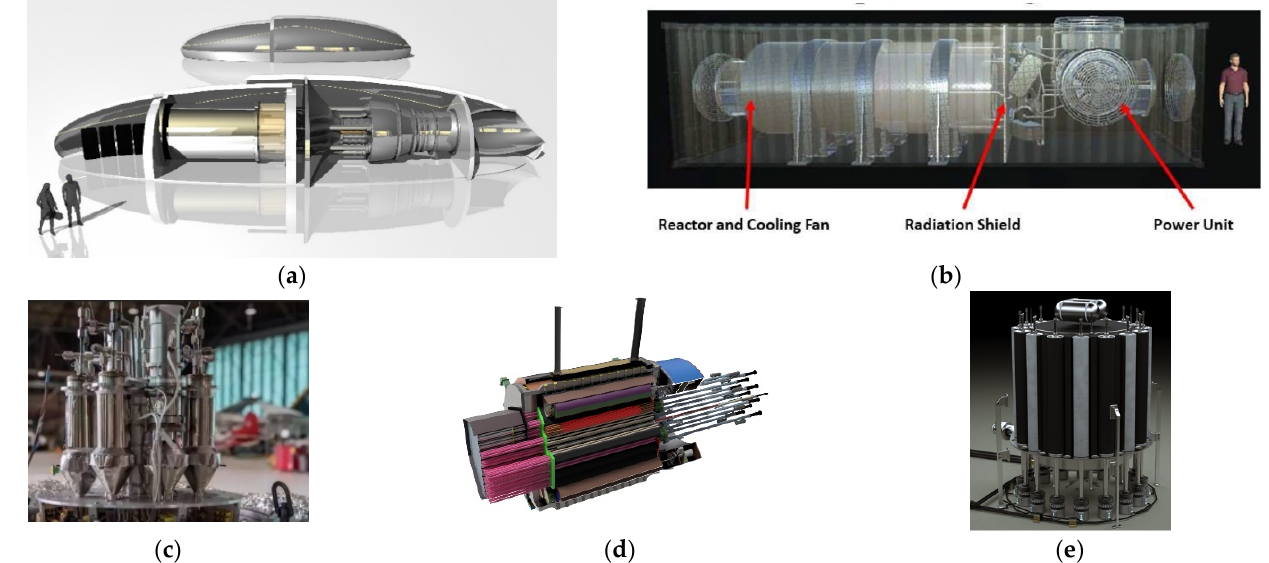
Figure 1. ( a ) MIT’s conceptualization of a nuclear battery (NB) with integrated gas turbine; ( b ) LANL’s Megapower [7]; ( c ) NASA and LANL’s KRUSTY/Kilopower reactor using Stirling engine technology for space applications [8]; ( d ) Westinghouse’s eVinci heat pipe micro-reactor [9]; ( e ) Radiant Nuclear’s high-temperature gas-cooled micro-reactor [10].